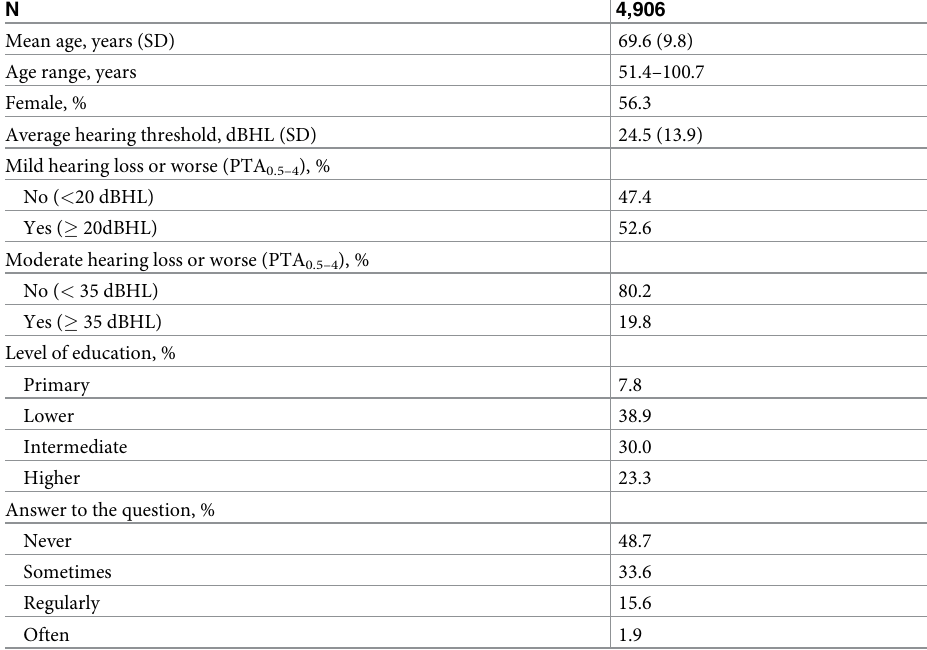
Table 1. Characteristics of participants who had been asked the question: ‘Do you have any difficulty with your hearing?’. Hearing thresholds were averaged over 0.5, 1, 2 & 4 kHz (PTA 0.5–4 ).